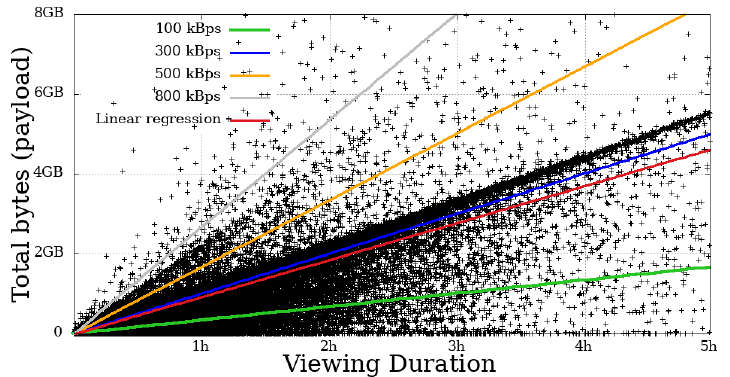
Figure 17. Bytes throughput per second of non-mobile users on the system in the broadcast Opening Rio 2016 Olympic